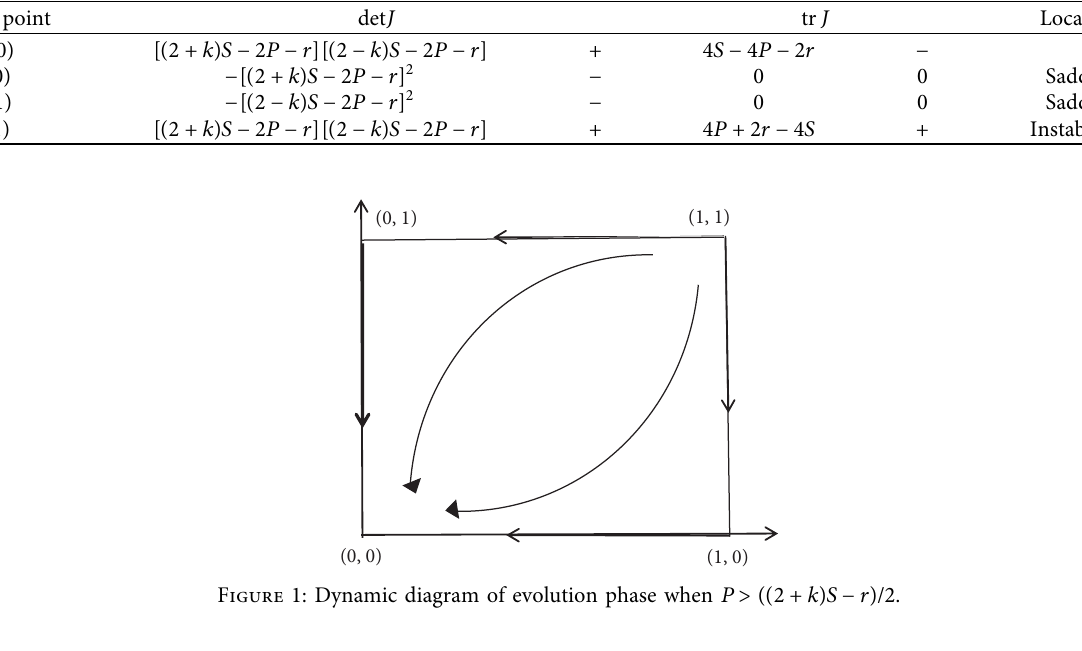
Table 2: Stability of stable points when P > (( 2 + k ) S − r ) /2.